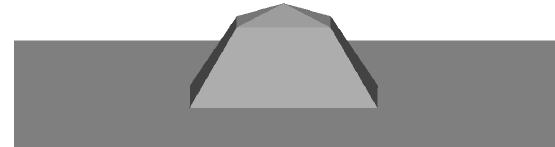
Figure 4: A pyramid scene model used to test the survey planning algorithm.